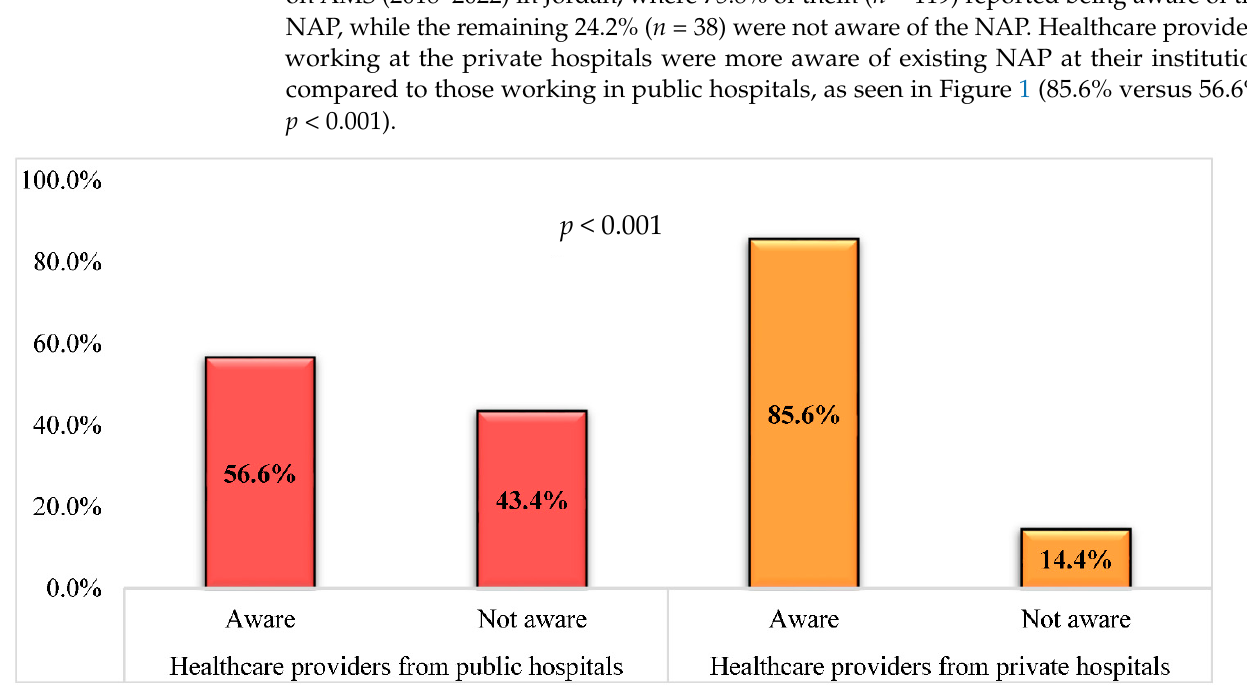
Figure 1. Differences between healthcare providers from public hospitals ( n = 53) and private hospitals ( n = 104) based on their awareness about the presence of the national action plan on antimicrobial stewardship (2018–2022) in Jordan. p -value was calculated using the Chi-squared test. On the other hand, healthcare providers were asked about the level of implementation of AMS activities at the hospitals where they work (Table 2). Only 43.9% of the healthcare providers ( n = 69) reported having an AMS committee in their hospital settings.